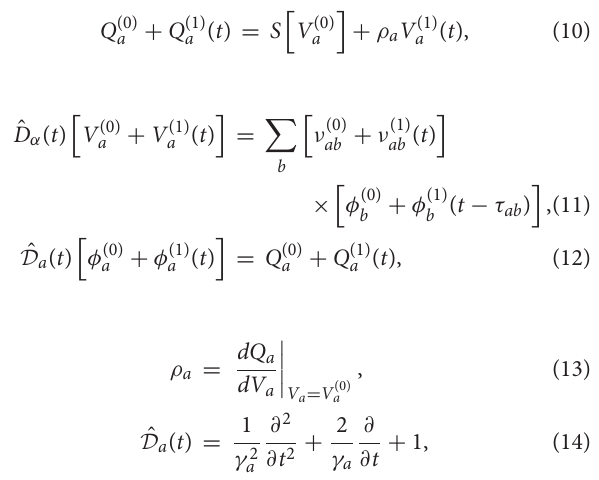
τ is 20 ms = ≈ τ re =